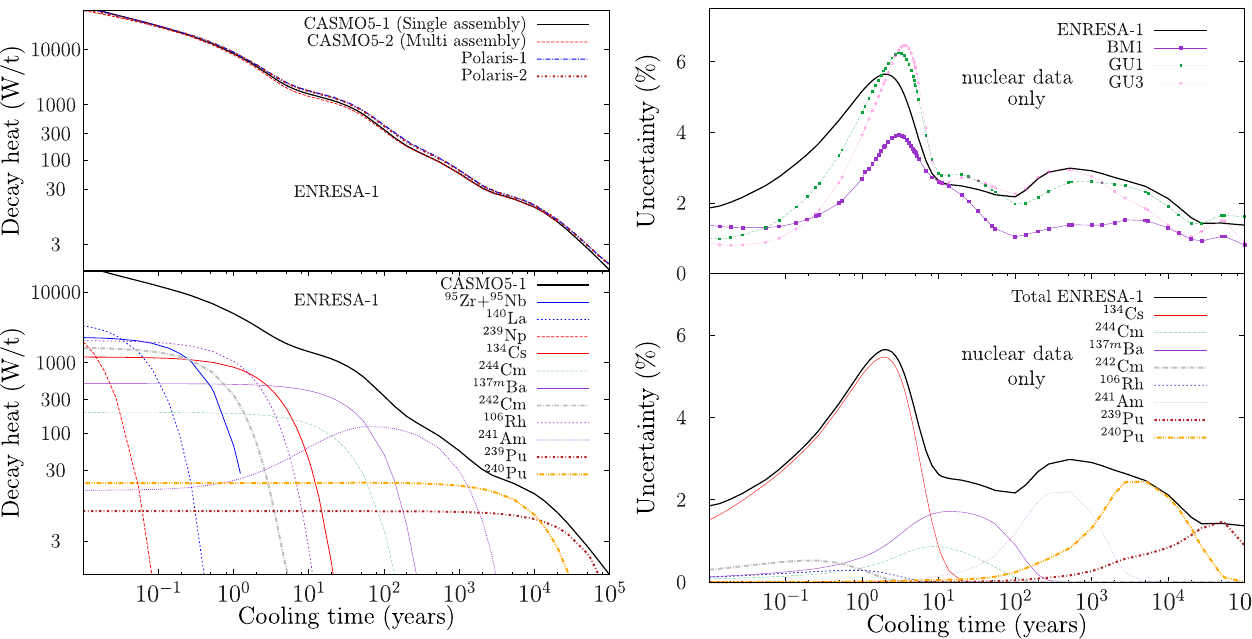
Fig. 3. Left: calculated decay heat for the segment containing the sample ENRESA-1. Right: calculated decay heat uncertainty for the same segment: comparison with other samples assuming same input uncertainties (top) and contributions to the total uncertainties (bottom).